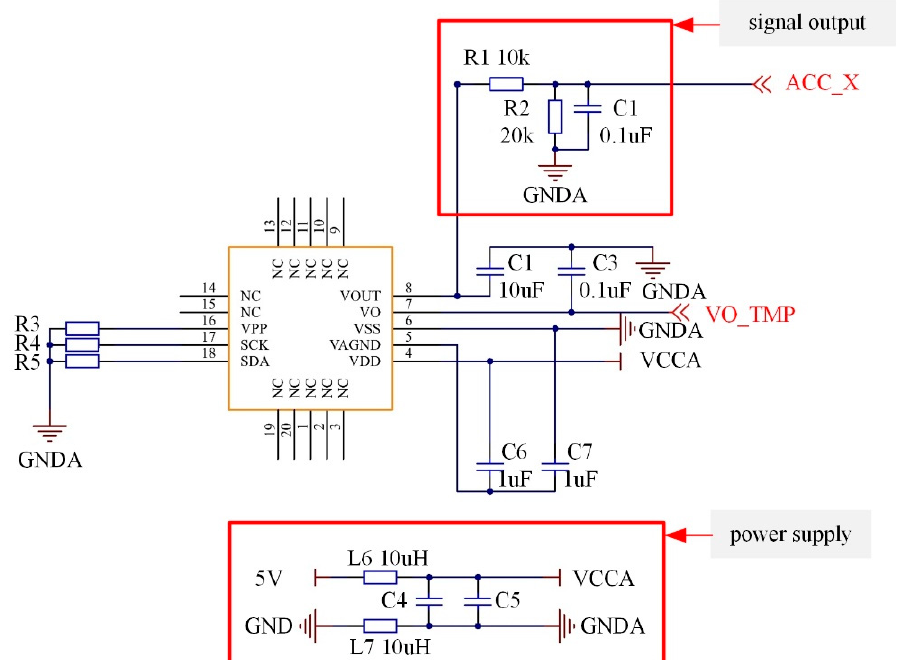
Figure 4. Circuit diagram of the accelerometer.